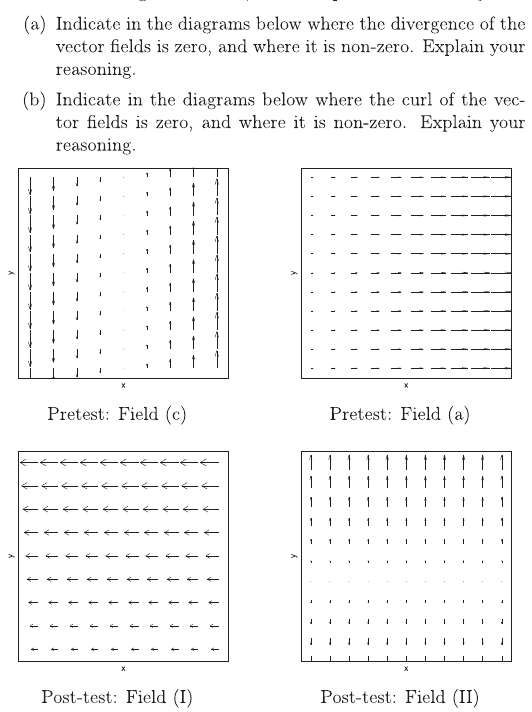
FIG. 7. Question on the pre- and post-test that were given to the students in order to determine to what extent they can decide where the divergence or curl is nonzero in a field vector plot. Fields (c) and (I) are similar and yield the same solution, as is the case for fields (a) and